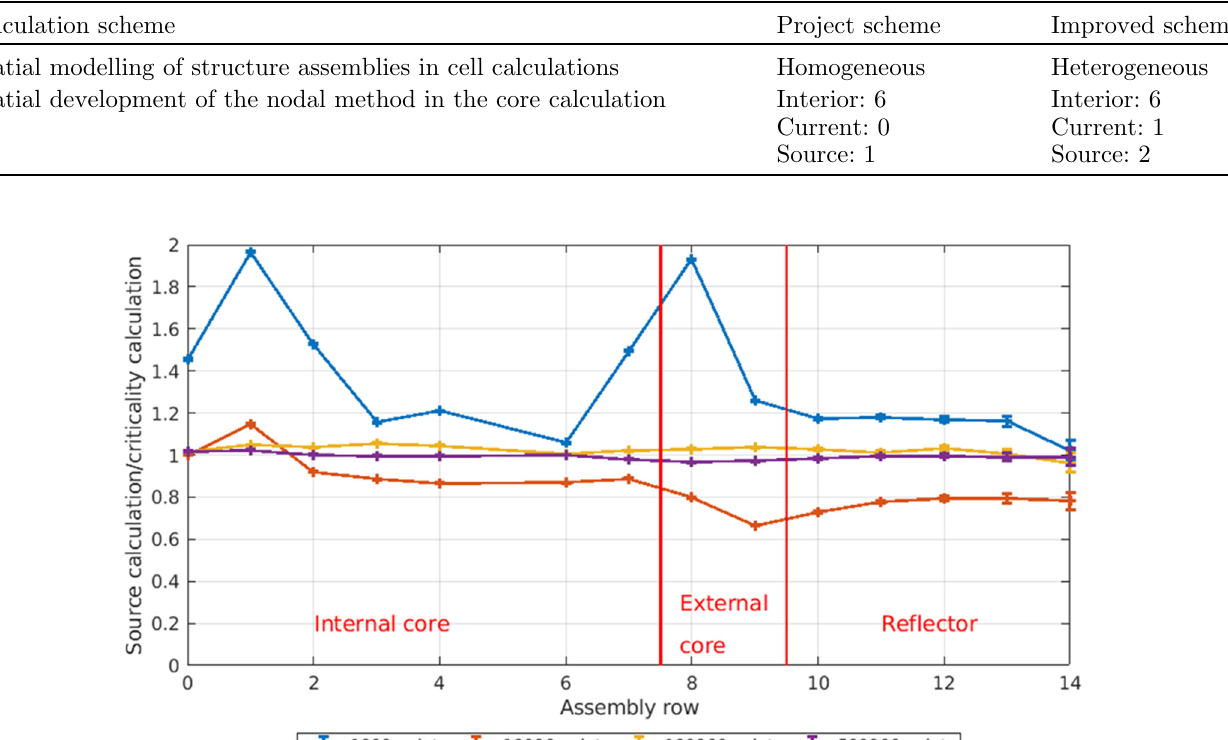
Table 1. Calculations schemes used in the ERANOS code.